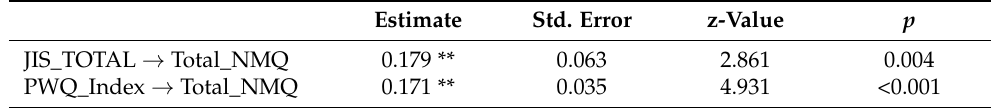
Table 4. Total effects path analysis regressions.